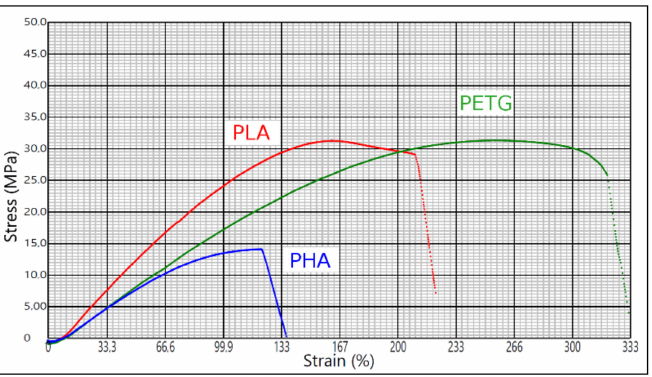
Figure 11. Comparison of tensile test of samples printed according to settings in Table 7. The tensile stress at break for PLA Prusament, PETG Prusament, and PHA Bio Wood Rosa is 31.2 MPa, 31.3 MPa, and 14.1 MPa, respectively. The elongation for PLA is 210%, PETG is 320%, and PHA is 123%. In terms of flexibility, PLA is the most rigid material. The most flexible is PETG. PHA has similar flexibility but brakes first. The force required to break PETG samples is twice as high. However, this does not mean that the PHA is not applicable, but it would be necessary to consider the maximum force usually applied in face